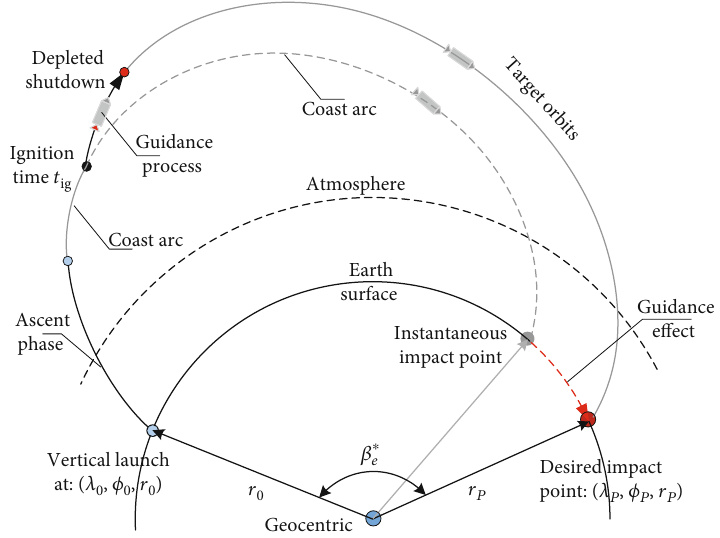
Figure 1: Typical launch process of the instantaneous impact point guidance for solid